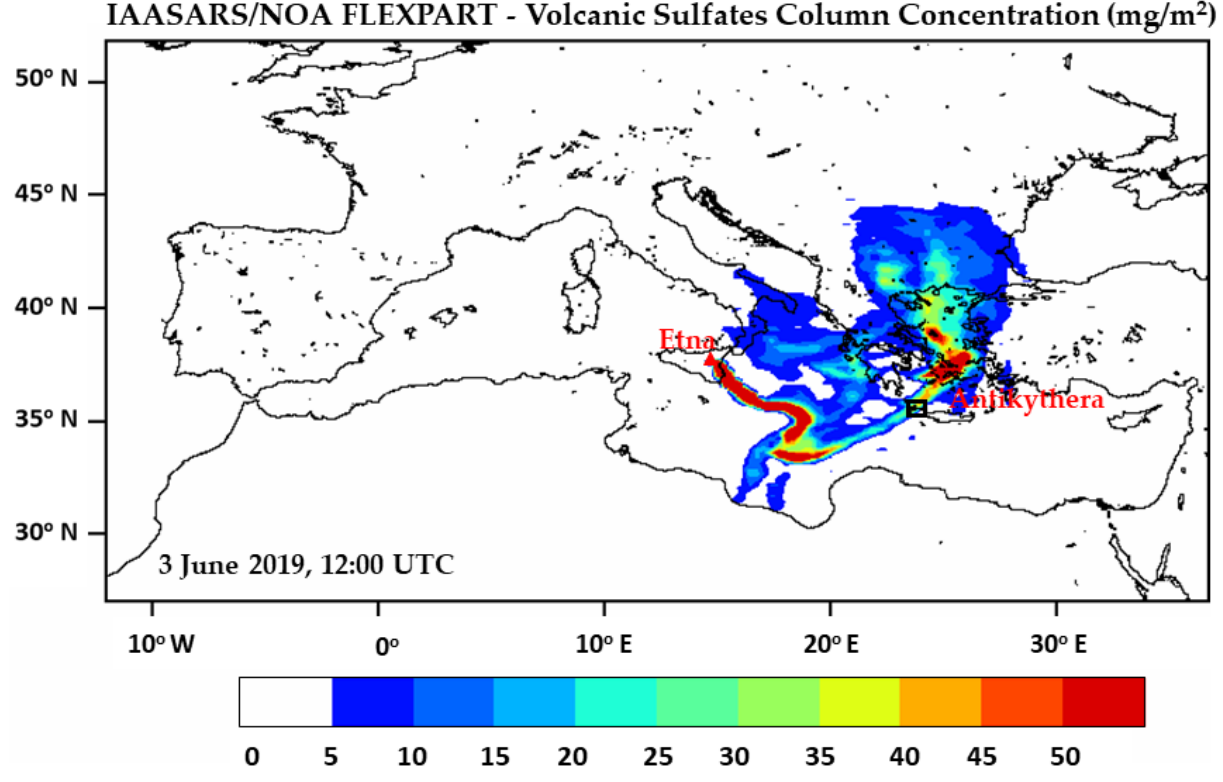
Figure A3. Simulated column concentration of sulfate particles (mg/m 2 ) originating from Etna, on 3 June 2019, 12:00 UTC, as simulated by FLEXPART-WRF using the SO 2 source term. The location of the Etna Volcano is marked with a red triangle and with black square the Antikythera